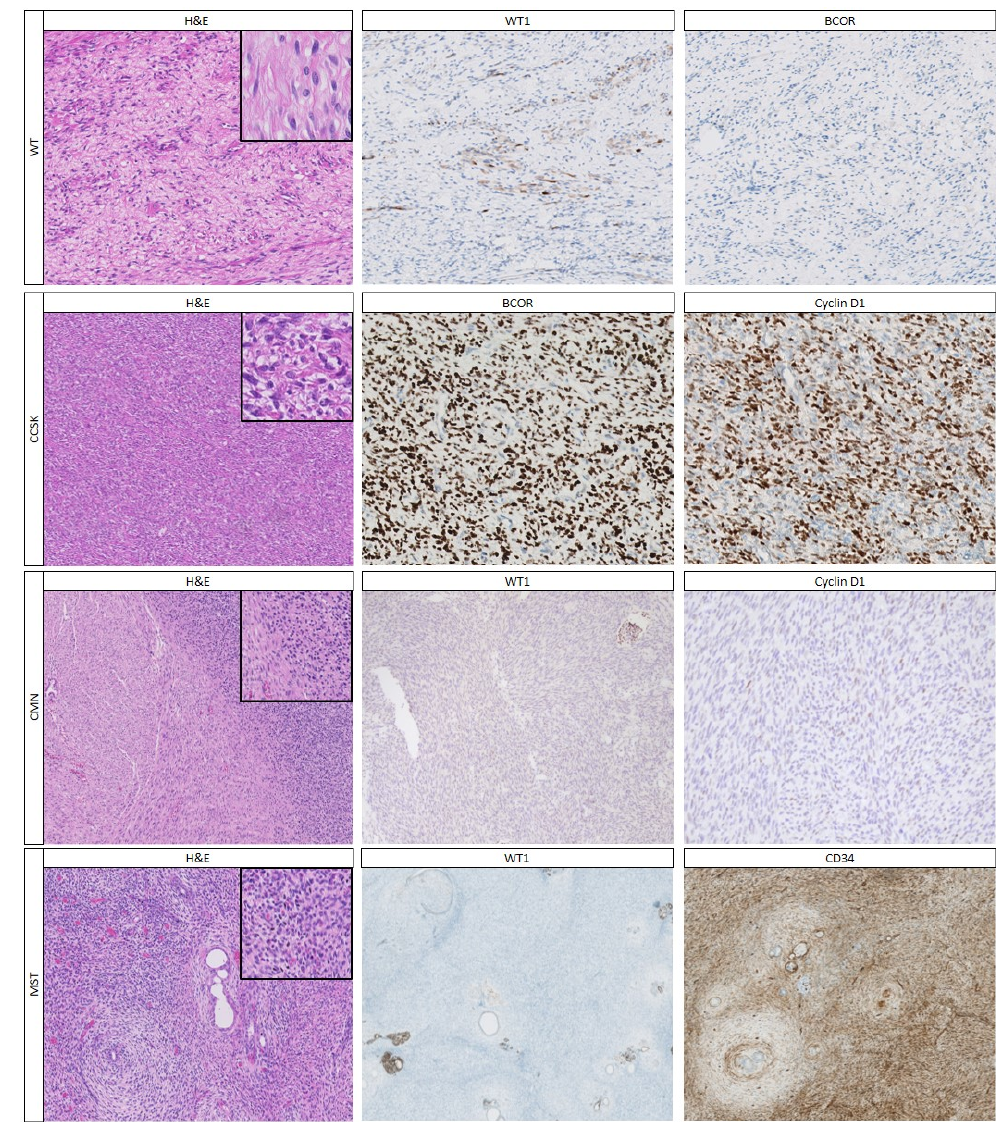
Figure 2. The most common pediatric renal tumors with a stromal pattern and their most important immunohistochemical stainings. The stromal type WT consists of spindle cells, which often shows more patchy or focal staining for WT-1 and they lack staining for BCL6 corepressor (BCOR). The classical pattern of a clear cell sarcoma of the kidney (CCSK) has a fine vasculature surrounding nests of rather monotonous cells (“chicken wire” vasculature), and the characteristic strong nuclear staining for BCOR as well as CyclinD1. A mixed type congenital mesoblastic nephroma (CMN) with hypercellular areas resembling the cellular subtype and less cellular areas resembling the classic subtype; the immunohistochemical pattern is rather indistinct, including lack of staining for WT1 and CyclinD1. Metanephric stromal tumor (MST), showing the formation of concentric rings of stroma surrounding some of the epithelial tubules (referred to as “onion skinning”); the stromal component of metanephric tumors lacks WT1 staining, but stains strongly with CD34. H&E and immunohistochemical stainings at 10× magnification; inset at 40× magnification.